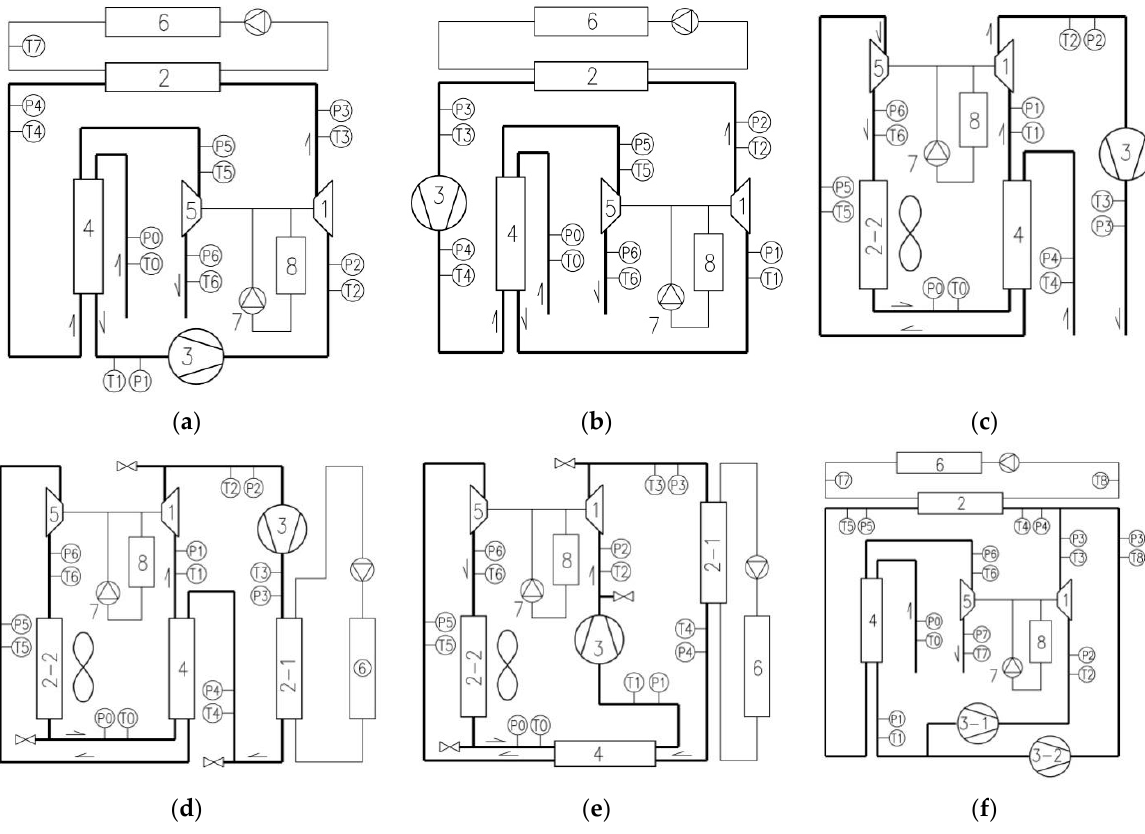
Figure 1. Different cycles of the air-reversed Brayton heat pump system with a turbocharger. 1: compressor, 2: heat exchanger, 3: blower, 4: preheater (regenerative), 5: turbine, 6: fan coil, 7: oil pump, 8: oil tank (P/T pressure sensor/temperature sensor). ( a ) Cycle A; ( b ) Cycle B; ( c ) Cycle C; ( d ) Cycle D; ( e ) Cycle E; ( f ) Cycle F.